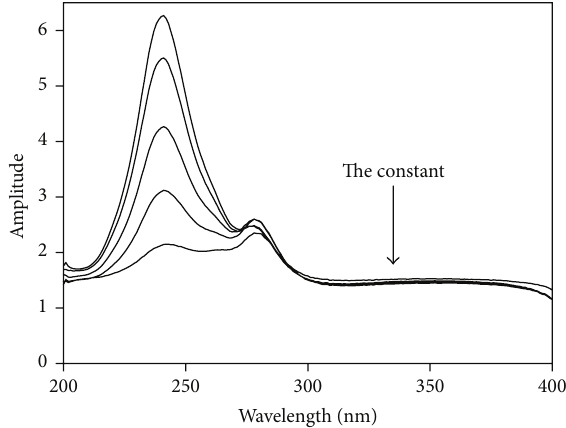
Figure 2: Zero-order absorption spectra of 8 𝜇 g/mL AA (- ⋅ - ⋅ - ⋅ -), 8 𝜇 g/mL RU (—), and a mixture of 4 𝜇 g/mL AA with 4 𝜇 g/mL RU (-----) using methanol as blank.